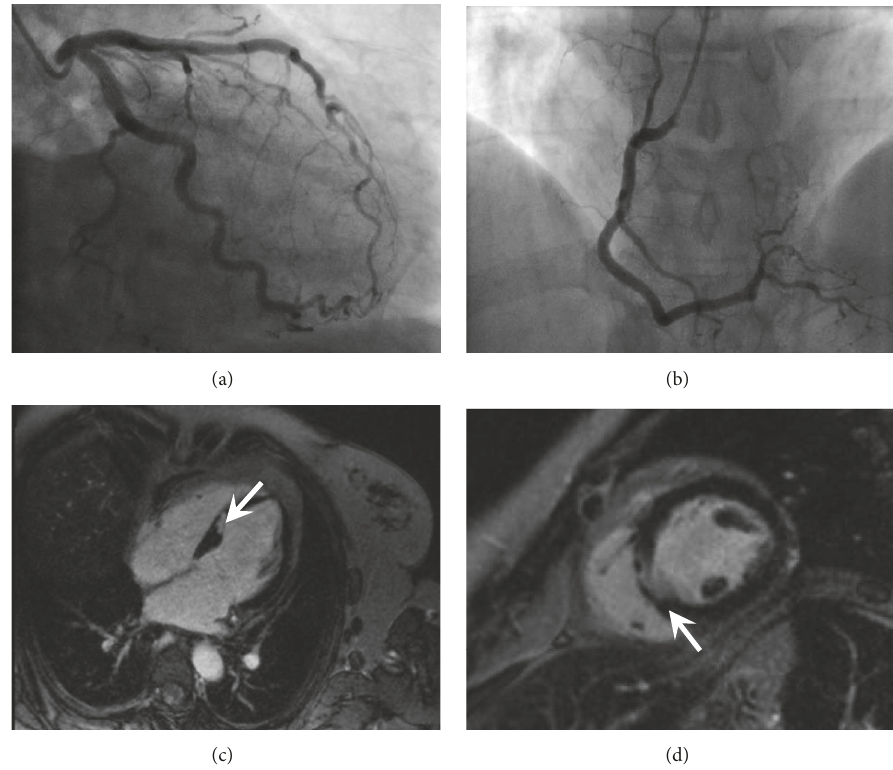
Figure 4: Cardiac imaging: (a) Coronary angiogram showing normal unobstructed left coronary artery. (b) Coronary angiogram showing normal unobstructed right coronary artery. (c) Left ventricle 4 chamber cardiac MRI late gadolinium enhancement image showing area of near transmural infarction in the mid septum. (d) Left ventricle short axis cardiac MRI late gadolinium enhancement image at the papillary muscle level showing area of near transmural infarction of the mid